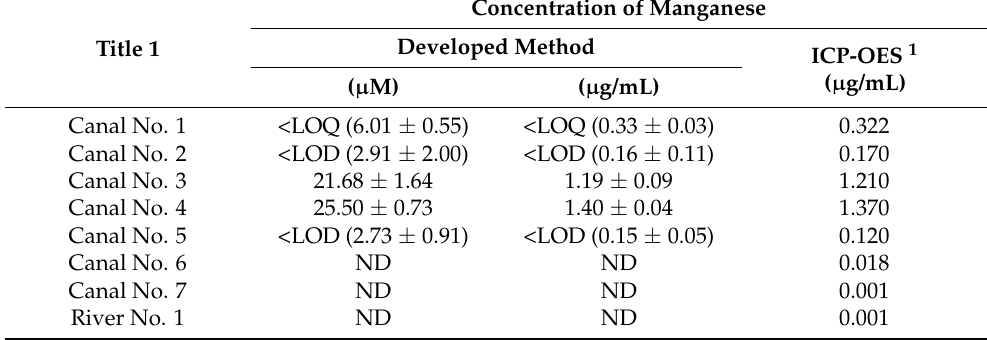
Table 1. Obtained concentrations of manganese in water samples ( n = 3) using the developed and reference